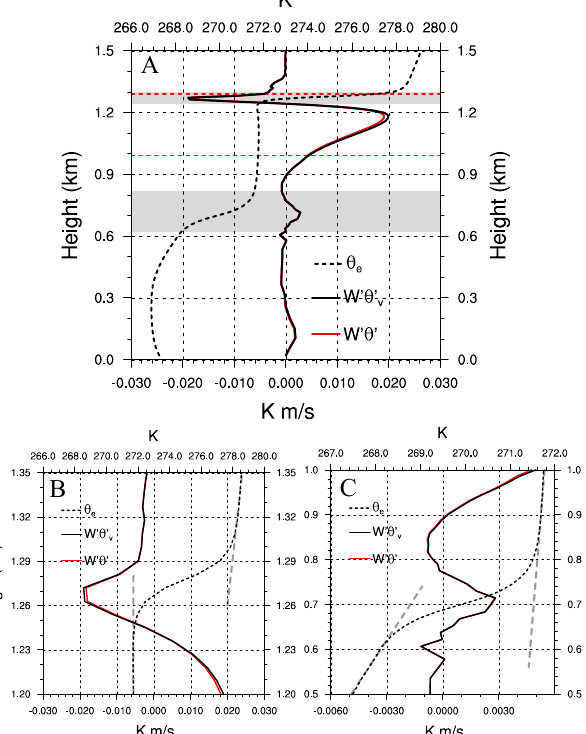
Fig. 8. Buoyancy fluxes averaged over the square box, where black(red) lines show w 0 θ 0 v ( w 0 θ 0 ) and equivalent potential temper- ature ( <θ e > ) is shown with a dashed line, in units of Kms − 1 and K, respectively. Cloud layer top and base indicated by red dashed lines. (A) Surface to 1.5km. Entrainment zones indicated with gray shading. (B) Cloud top entrainment zone. (C) Below mixed layer entrainment zone. Long dashed gray lines show constant θ e slopes used to estimate the depth of the entrainment zones: 1.24– 1.3km=60m at cloud top and 0.62–0.82km=200m below mixed